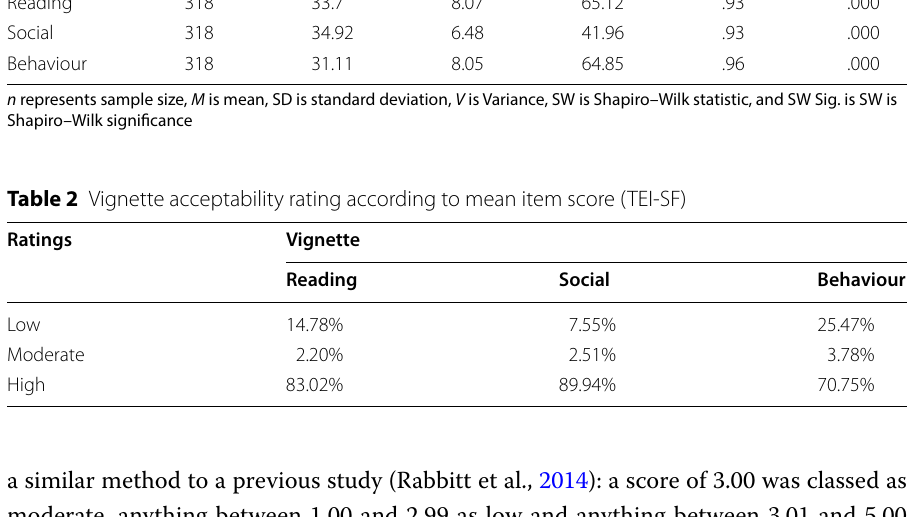
Table 1 Descriptive statistics for means comparison of vignette using acceptability